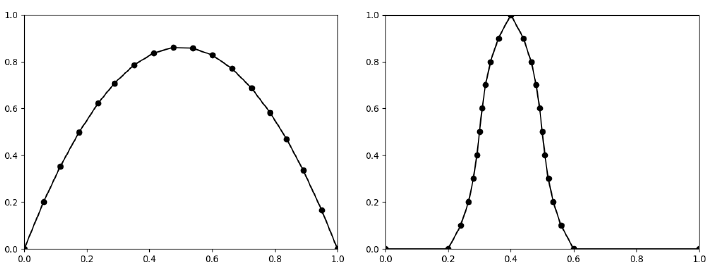
given by 18 points ( left ) and the fuzzy set A 4 4